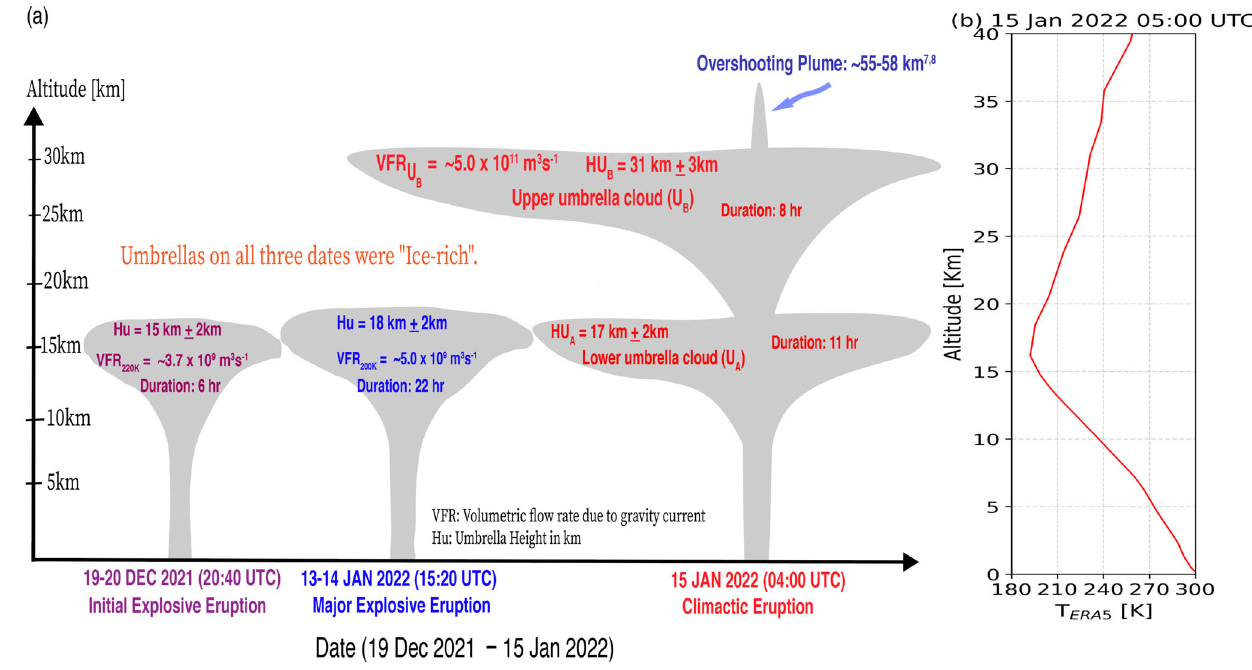
Fig. 4 Summary of chronology of HTHH umbrellas characteristics. a Schematic summarizing our fi ndings related to HTHH explosive eruptions. b Typical clear-sky temperature pro fi le on 15 January 2022 at 05:00:00 UTC over